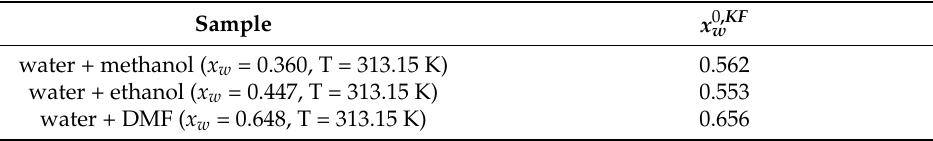
Table 2. The amount of water x 0 w upon equilibration.